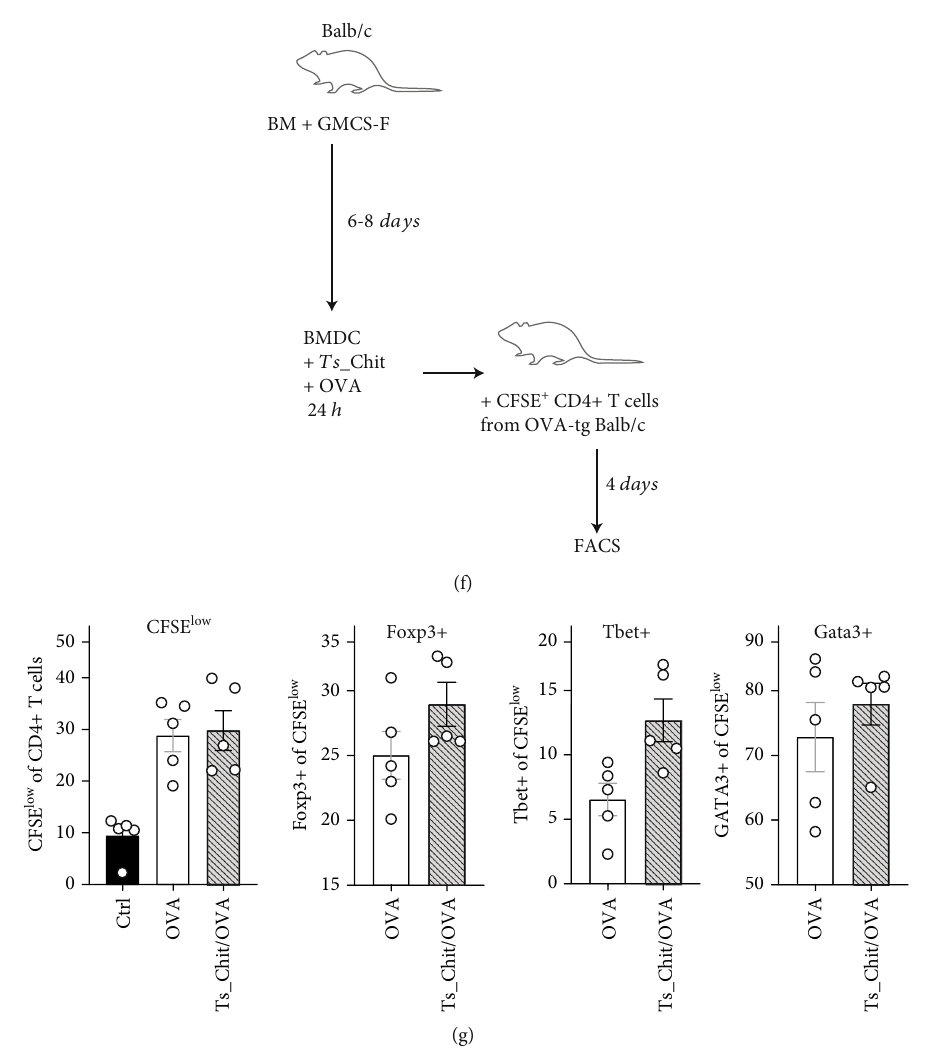
Figure 3: No direct e ff ects of T. suis chitinase on DC activation or T cell proliferation. (a) Experimental setup of analyzing e ff ects of Ts- Chit on activation marker und cytokine release from bone marrow-derived dendritic cells. (b) MFI of MHCII, CD86, and Ox40L expression analyzed by fl ow cytometry. Data are presented as individual values and mean ± SEM of n = 9 animals from n = 3 separate experiments. (c) Cytokine levels of IL-6, IL-12p40, IL-10, and TNF α of BMDC supernatants harvested 24.5h following TLR ligation and Ts- Chit treatment detected by ELISA. Data are presented as individual values and mean ± SEM of n = 7 -9 animals from n = 3 separate experiments. Statistical signi fi cance was assessed using a two-tailed Mann-Whitney test, and results are indicated by ∗∗ p ≤ 0 : 01 . (d) Experimental setup of analyzing e ff ects of Ts- Chit on CD3e/CD28-induced T cell proliferation using CFSE-labeled splenocytes. (e) Exemplary histogram of CFSE dilution in CD4 + T cells with (gray) and without (black) anti-CD3e/CD28 stimulation and summarized in bar graphs for CD4 and CD8 T cell proliferation. Data are presented as individual values and mean ± SEM of n = 6 animals from n = 2 separate experiments. (f) Experimental setup of analyzing e ff ects of Ts- Chit on antigen-dependent T cell proliferation and di ff erentiation. MACS-puri fi ed CD4 + T cells from DO11.10 mice were cocultured with OVA-loaded BMDC in the absence or presence of Ts- Chit. (g) CFSE dilution of CD4 + T cells and transcription factor expression of Foxp3, Tbet, and GATA3 were analyzed in CFSE low CD4 + T cell and were analyzed by fl ow cytometry and presented as summarized for n =5 mice from two independent